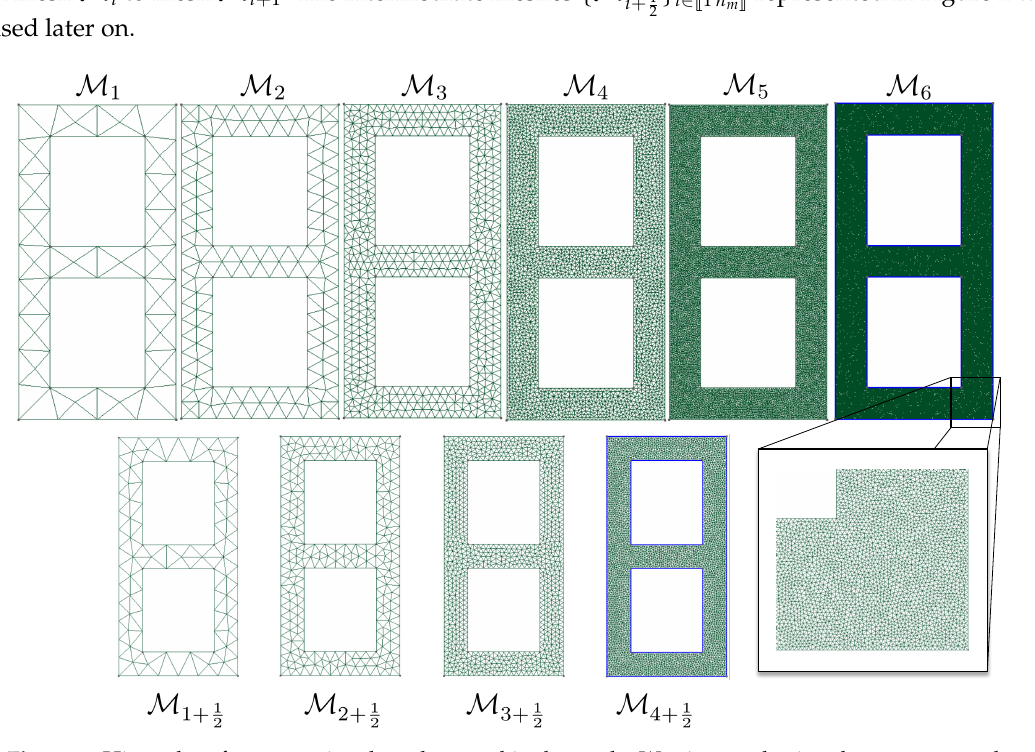
Figure 2. Hierarchy of computational meshes used in the study. We aim at selecting the coarsest mesh that delivers the targeted distributions up to a user-defined numerical accuracy. The second line of meshes is only used for error estimation